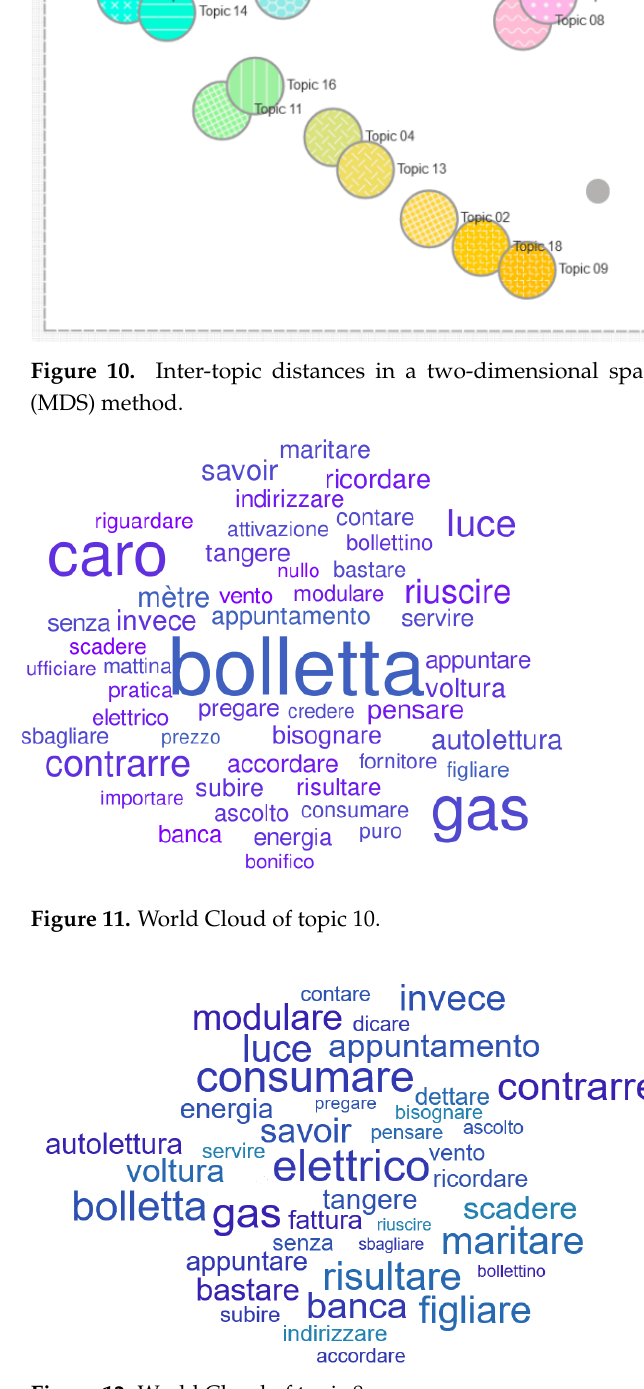
Figure 12. World Cloud of topic